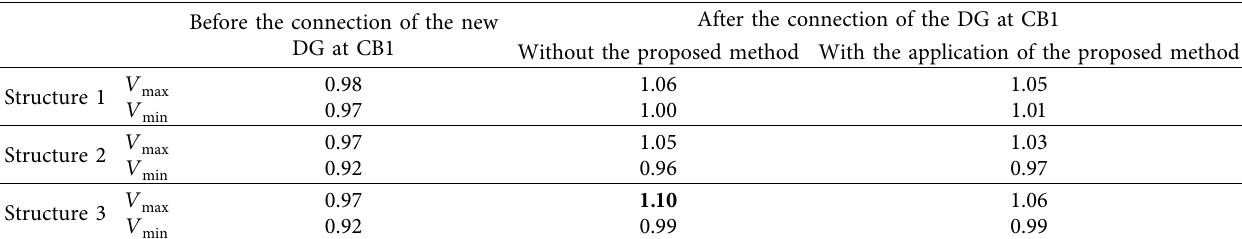
Table 5: Voltage profile before the connection of the new DG, after the connection at CB1, with and without the proposed method. After the connection of the DG at CB1 Before the connection of the new DG at CB1 Without the proposed method With the application of the proposed method V max Structure 1 V Structure 2